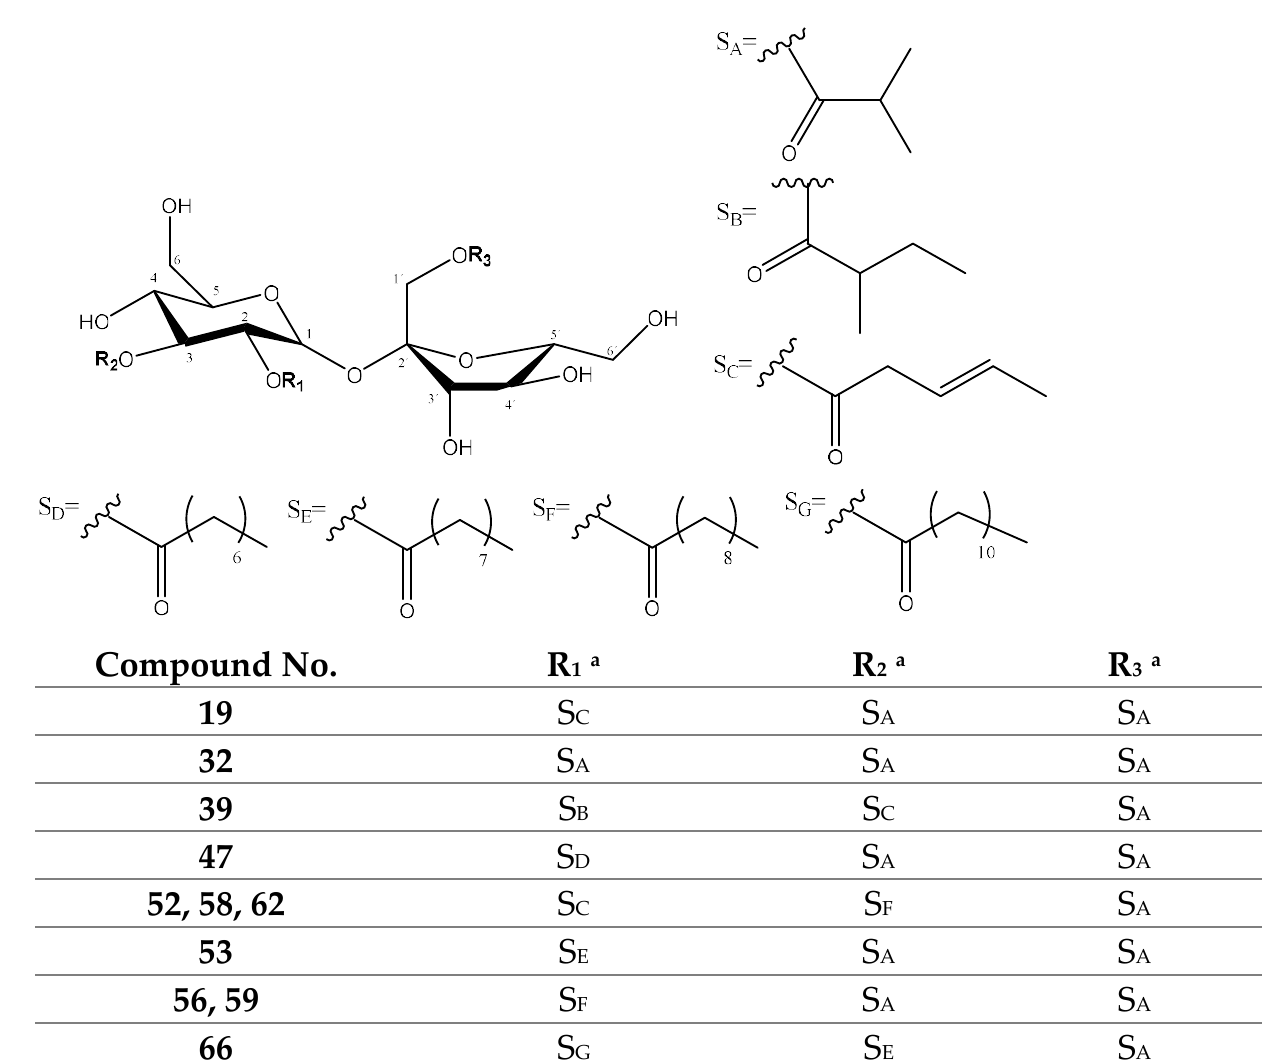
Figure 14. Trisubstituted sucrose ester derivatives.